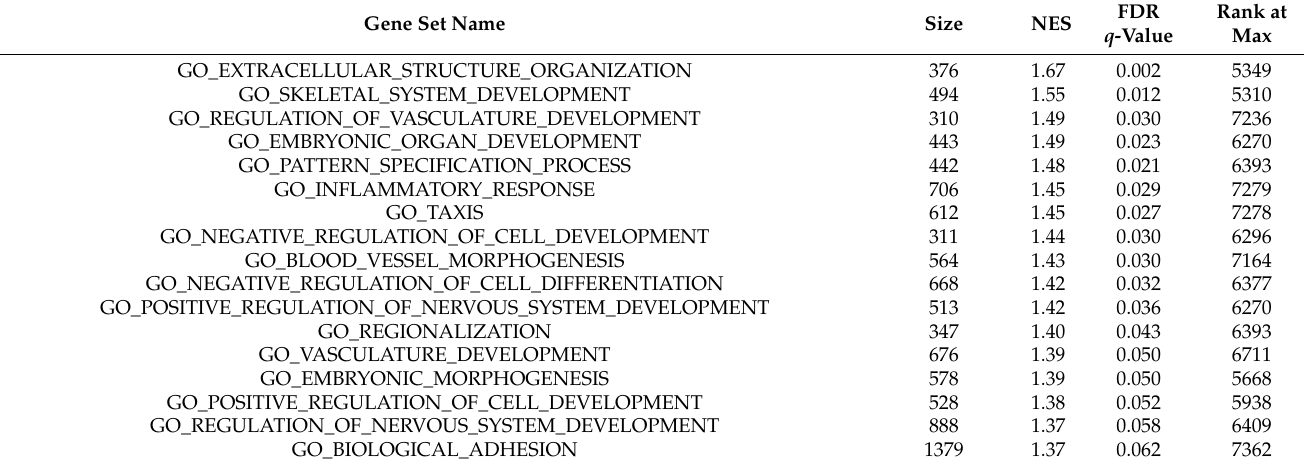
Table 6. Gene Ontology biological process terms (size > 300) that were significantly upregulated (FDR < 0.25) in the tunica media compared to the intimal thickening of the closing DA tissues (Cases 2 and